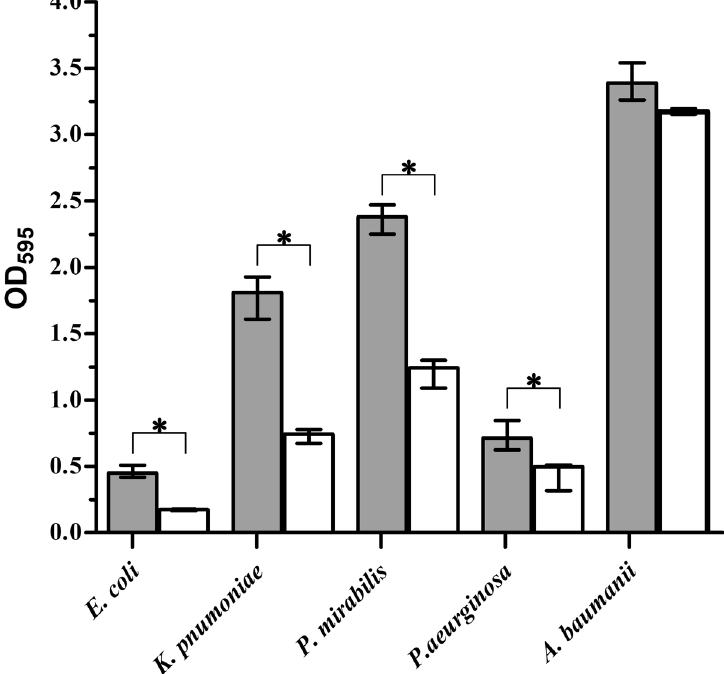
Figure 4. Impact of Acacia nilotica aqueous extract on biofilm of some uropathogenic isolates. Quantitative determination of biofilm amount of the isolated uropathogens as control (gray bars) and after treatment with Acacia nilotica aqueous extract (open bars). After an additional 24 h biofilm formation was quantified by crystal violet staining and subsequent determination of the OD 595 . Shown are the medians from at least three independent measurements. The error bars indicate the interquartile range. Significant differences between the data sets are marked by asterisks ( P < 0.05; Kruskal–Wallis test and post hoc Dunn’s multiple comparisons).